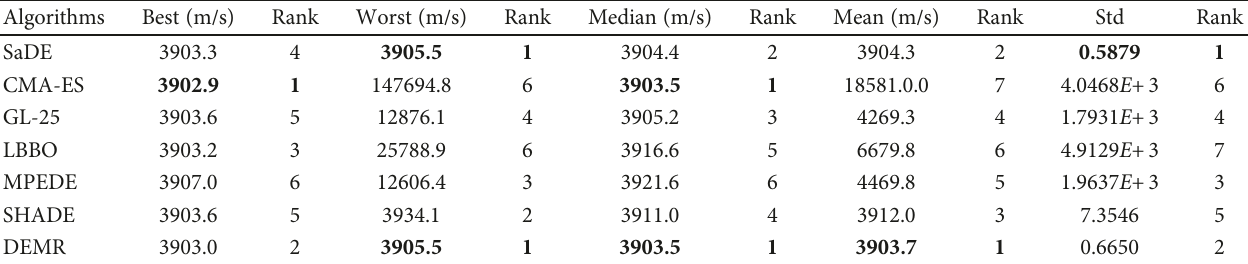
Table 7: Results for Earth-Moon low-energy transfer trajectory optimization in three-dimensional space with widened ranges. Algorithms